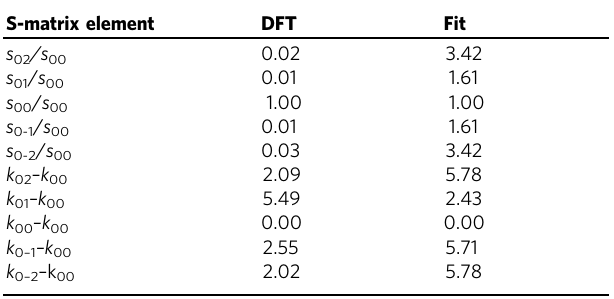
Relativechangesofthemagnitudes( s fn )andphases( k fn )oftheS-matrixelementsforscattering from an initial ( n ) m J state in J = 2 to the fi nal ( f ) m J 0 = 0 state in J 0 = 0 from the DFT calculations and from the best fi t to the experimental data.